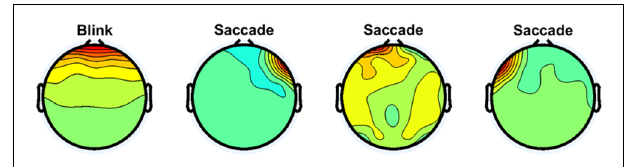
FIGURE 2 | Independent components regarded as eye movement artifacts for subject 1.